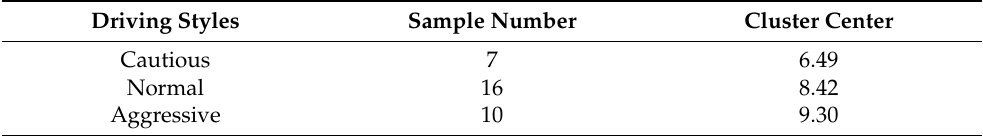
Table 2. Drivers information